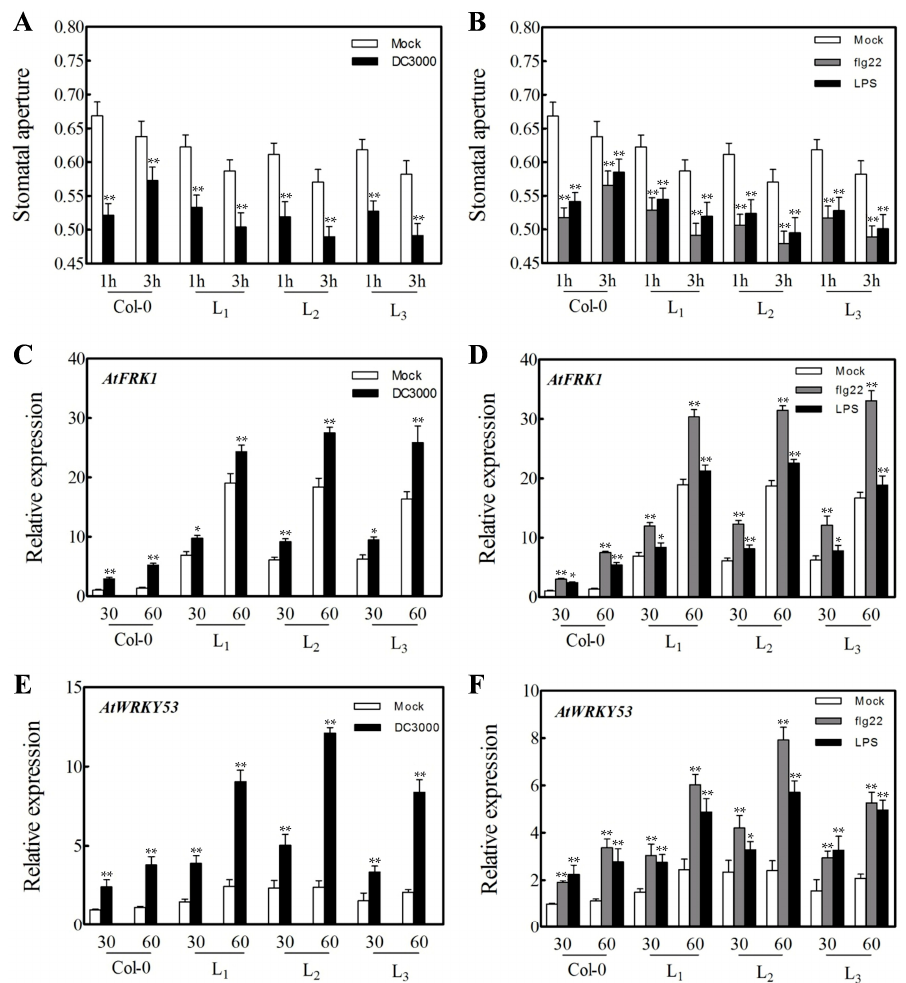
Figure 8. Response of stomatal apertures to Pst DC3000 infection, or flg22 and LPS treatment in transgenic A. thaliana and Col-0 leaves. ( A , B ) Statistical analysis of stomatal apertures (width/length; µm) following 1h and 3h of incubation. Data represent the means ± standard deviation from three independent experiments with at least 60 stomata per sample. Asterisks indicate statistical significance (** p < 0.01, one-way ANOVA) between transgenic A. thaliana and Col-0. ( C – F ) Expression analysis of stomatal immunity response related genes in transgenic A. thaliana lines and Col-0 plants at 1h and 3h following inoculation with Pst DC3000, flg22 or LPS. Data represent the means ± standard deviation from three independent experiments. Asterisks indicate statistical significance (* 0.01 < p < 0.05, ** p < 0.01, one-way ANOVA) between transgenic A. thaliana lines and Col-0.